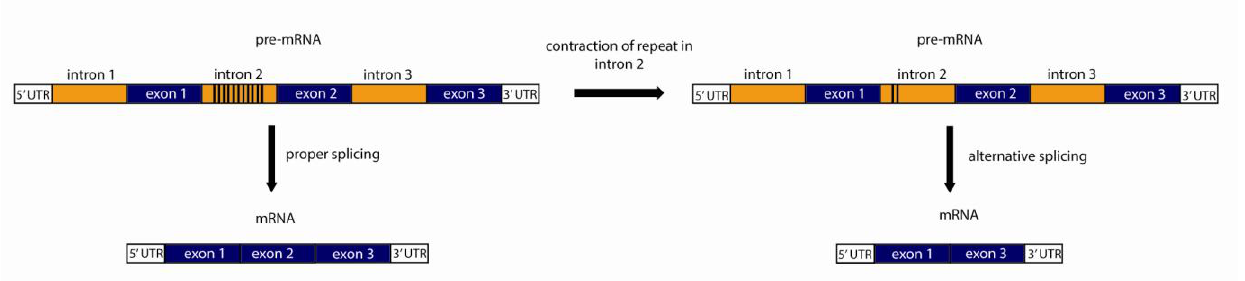
Figure 4. Variable intronic TRs regulate mRNA splicing. ( a ) A variable TR in intron 2 in the pre-mRNA transcript enables proper splicing to form a fully-functioning, normal mRNA transcript; ( b ) Shortening of intron 2 repeat results in an alternatively spliced (non-productive) transcript missing exon 2, which does not produce any functional